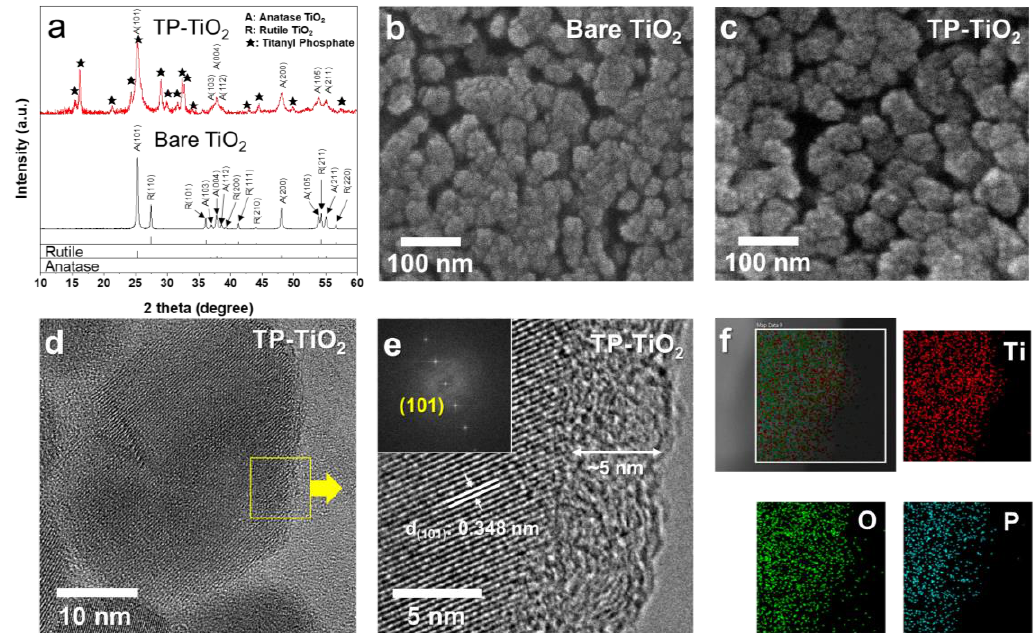
Figure 1. ( a ) XRD pattern of bare and TP-TiO 2 . SEM images of bare ( a ) and TP-TiO 2 ( b ). ( d ) and ( e ) HR-TEM images of TP-TiO 2 . The inserted image is a reduced FFT pattern. ( f ) HAADF TEM image and EDS elemental mapping of Ti, O and P atoms for TP-TiO 2 .